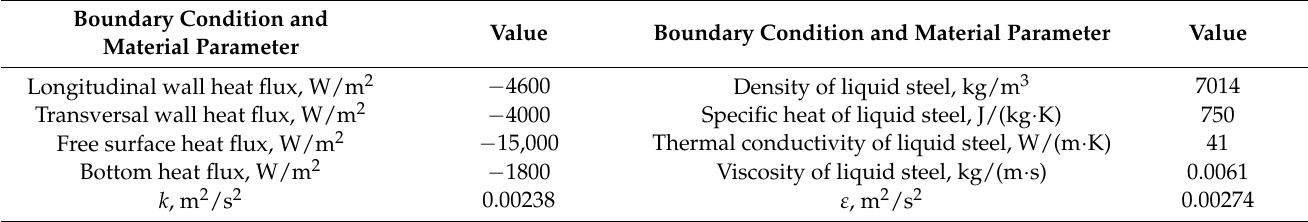
Table 5. Boundary conditions and material